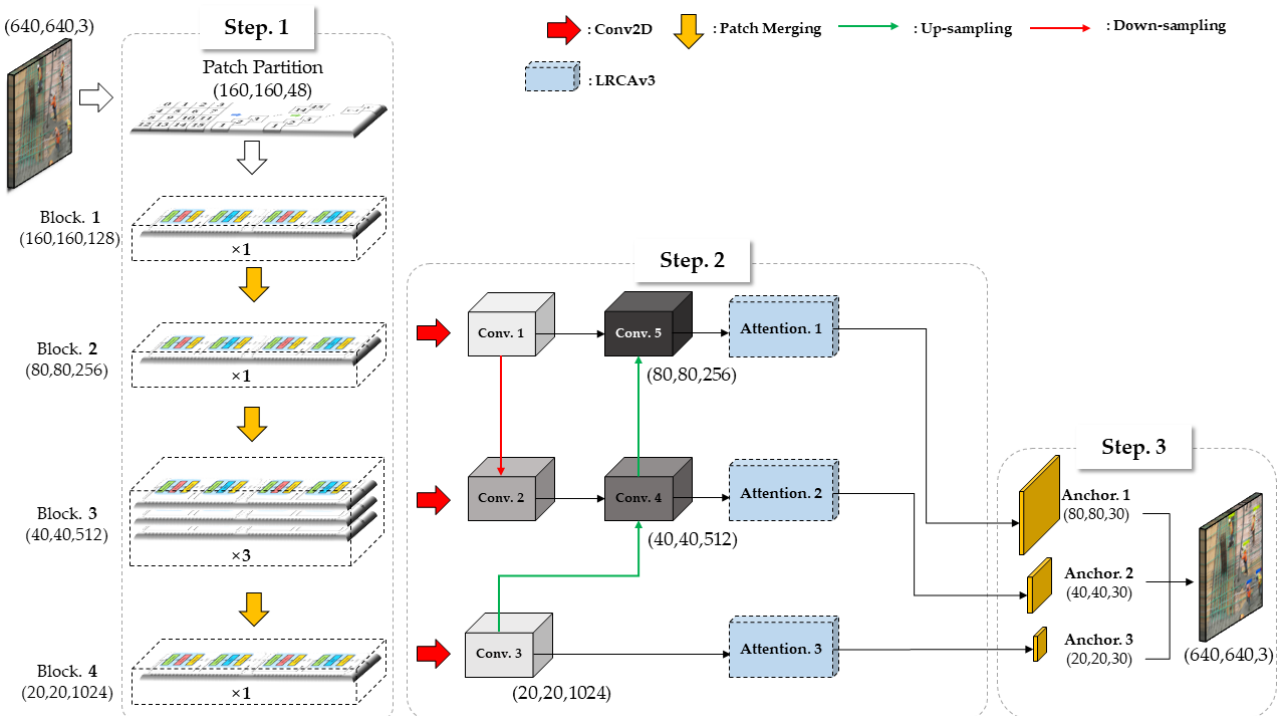
Figure 4. The helmet detection network applied to UAV inspection systems consists of three main steps.